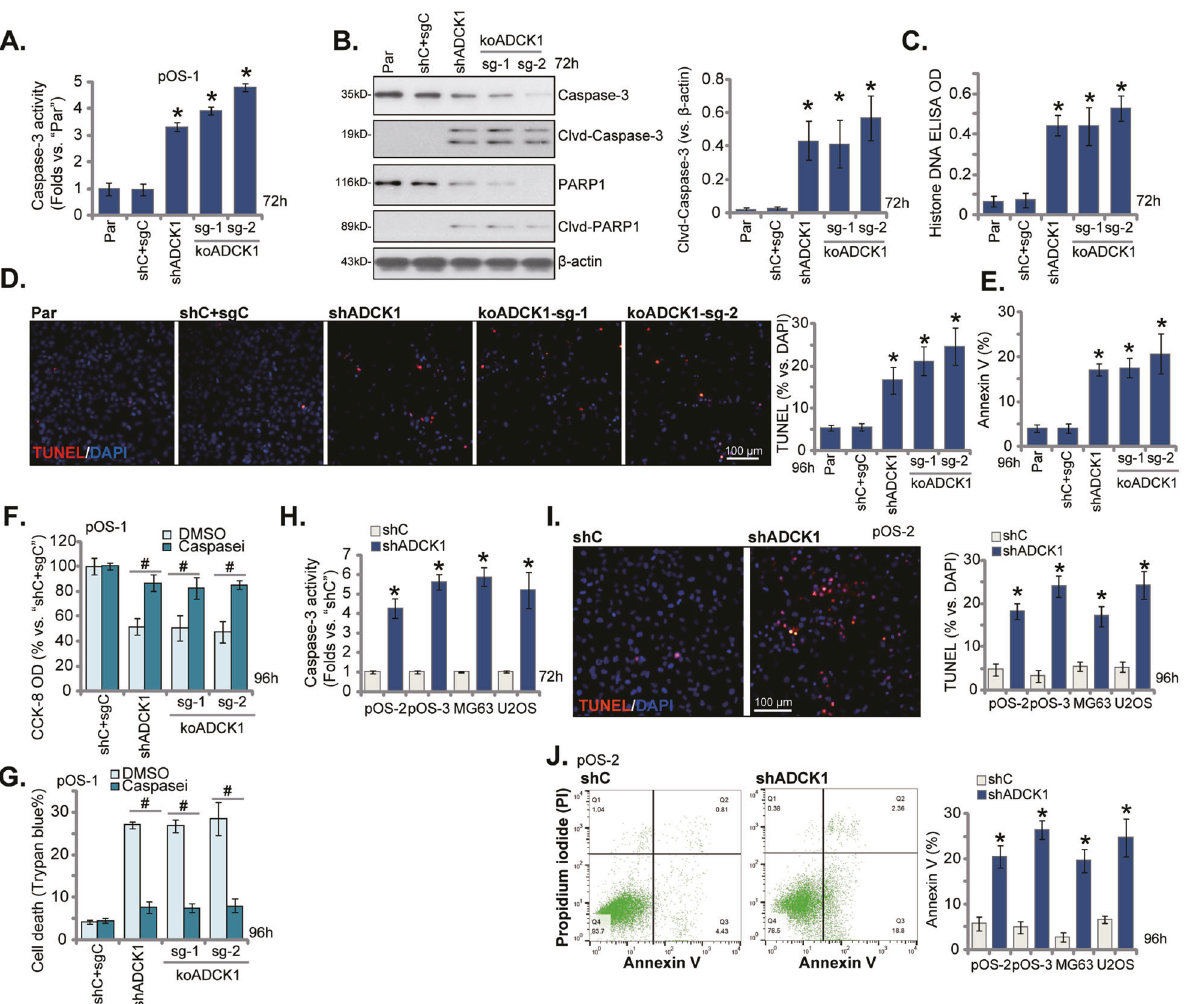
Fig. 3 ADCK1 silencing or KO provokes caspase and apoptosis activation in OS cells. Stable pOS-1 primary cells, bearing the lentiviral ADCK1 shRNA ( “ shADCK1 ” ), the lentiviral CRISPR/Cas9 construct with sgRNA targeting ADCK1 , “ koADCK1-sg-1 ” and “ koADCK1-sg-2 ” , or the lentiviral scramble control shRNA plus the CRISPR/Cas9 empty vector ( “ shC + sgC ” ), were established and cultured for applied time periods; The relative caspase-3 activity ( A ), expression of apoptosis-associated proteins ( B ) and Histone-bound DNA contents (ELISA OD, C ) were tested; Cell apoptosis was tested by nuclear TUNEL staining ( D ) and Annexin V FACS ( E ) assays. The above cells were treated with the pan caspase inhibitor z-VAD-fmk ( “ Caspasei, 40 μ M) or the vehicle control ( “ DMSO ” , 0.1%), and cultured for 96 h, cell viability and cell death were tested by CCK-8 ( F ) and Trypan blue staining ( G ) assays, respectively. The primary human OS cells (pOS-2 and pOS-3) as well as the established lines (MG63 and U2OS), expressing the lentiviral ADCK1 shRNA ( “ shADCK1 ” ) or the lentiviral scramble control shRNA ( “ shC ” ), were established and cultured for applied time periods; The relative caspase-3 activity ( H ) and cell apoptosis ( I , J ) were tested similarly. “ Par ” stands for the parental control cells. Data were presented as mean ± standard deviation (SD, n = 5). * P < 0.05 vs. “ Par ” / “ shC ” cells. # P < 0.05 vs. “ DMSO ” treatment ( F , G ). The experiments were repeated fi ve times with similar results obtained. Scale bar = 100 μ m ( D , I